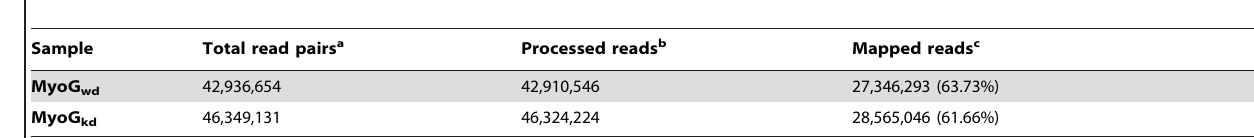
Table 1. Number of single replicate RNA-Seq reads across MyoG wd and MyoG kd samples.